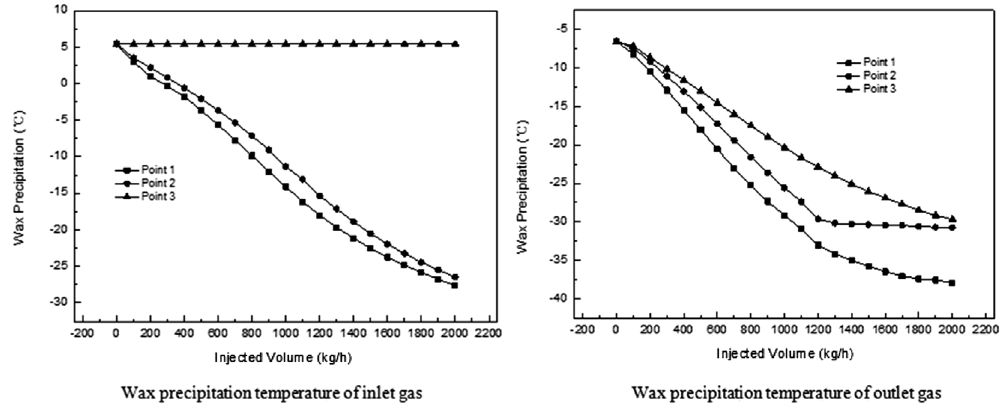
Fig. 11. The variation of wax precipitation temperature of the inlet/outlet gas of high-pressure separator with the injected